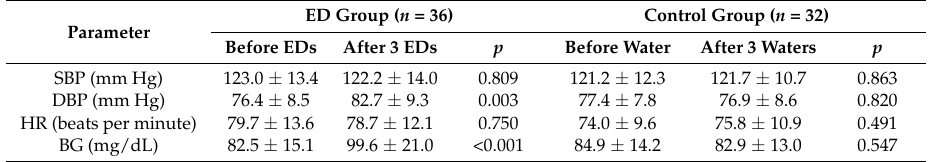
Data are mean ± SD; Statistical significance at p < 0.05. SBP—systolic blood pressure; DBP—diastolic blood pressure; HR—heart rate; BG—blood